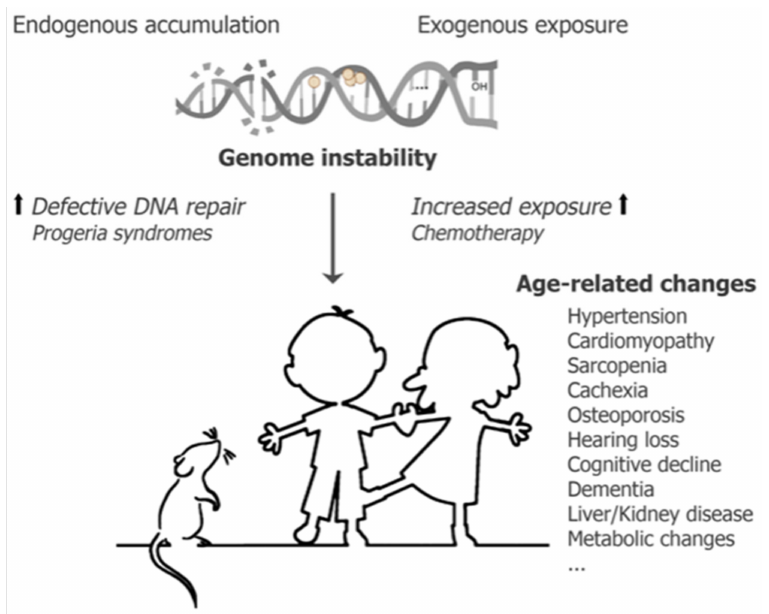
Figure 3. Genome instability induces premature aging. Persisting DNA damage, originating from both endogenous and exogenous sources, normally results in the onset of aging pathologies. These consequences are accelerated either when DNA repair processes are defective, in the case of progeria syndromes and thus more endogenous lesions persist, or when exogenous exposure is increased as during chemotherapy